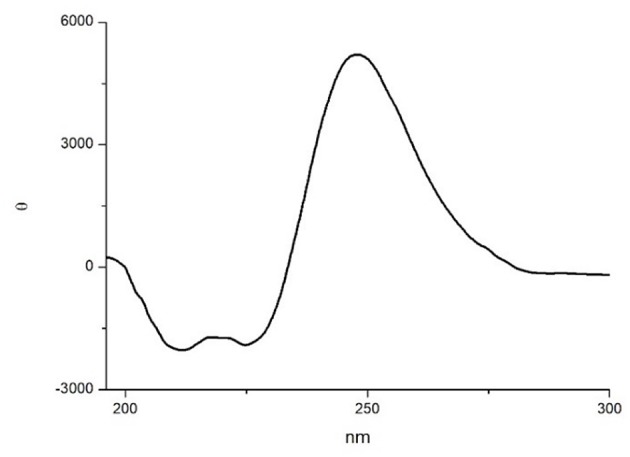
CD spectrum of compound 10 in CH3CN (0.1 mM CH3CN solution).